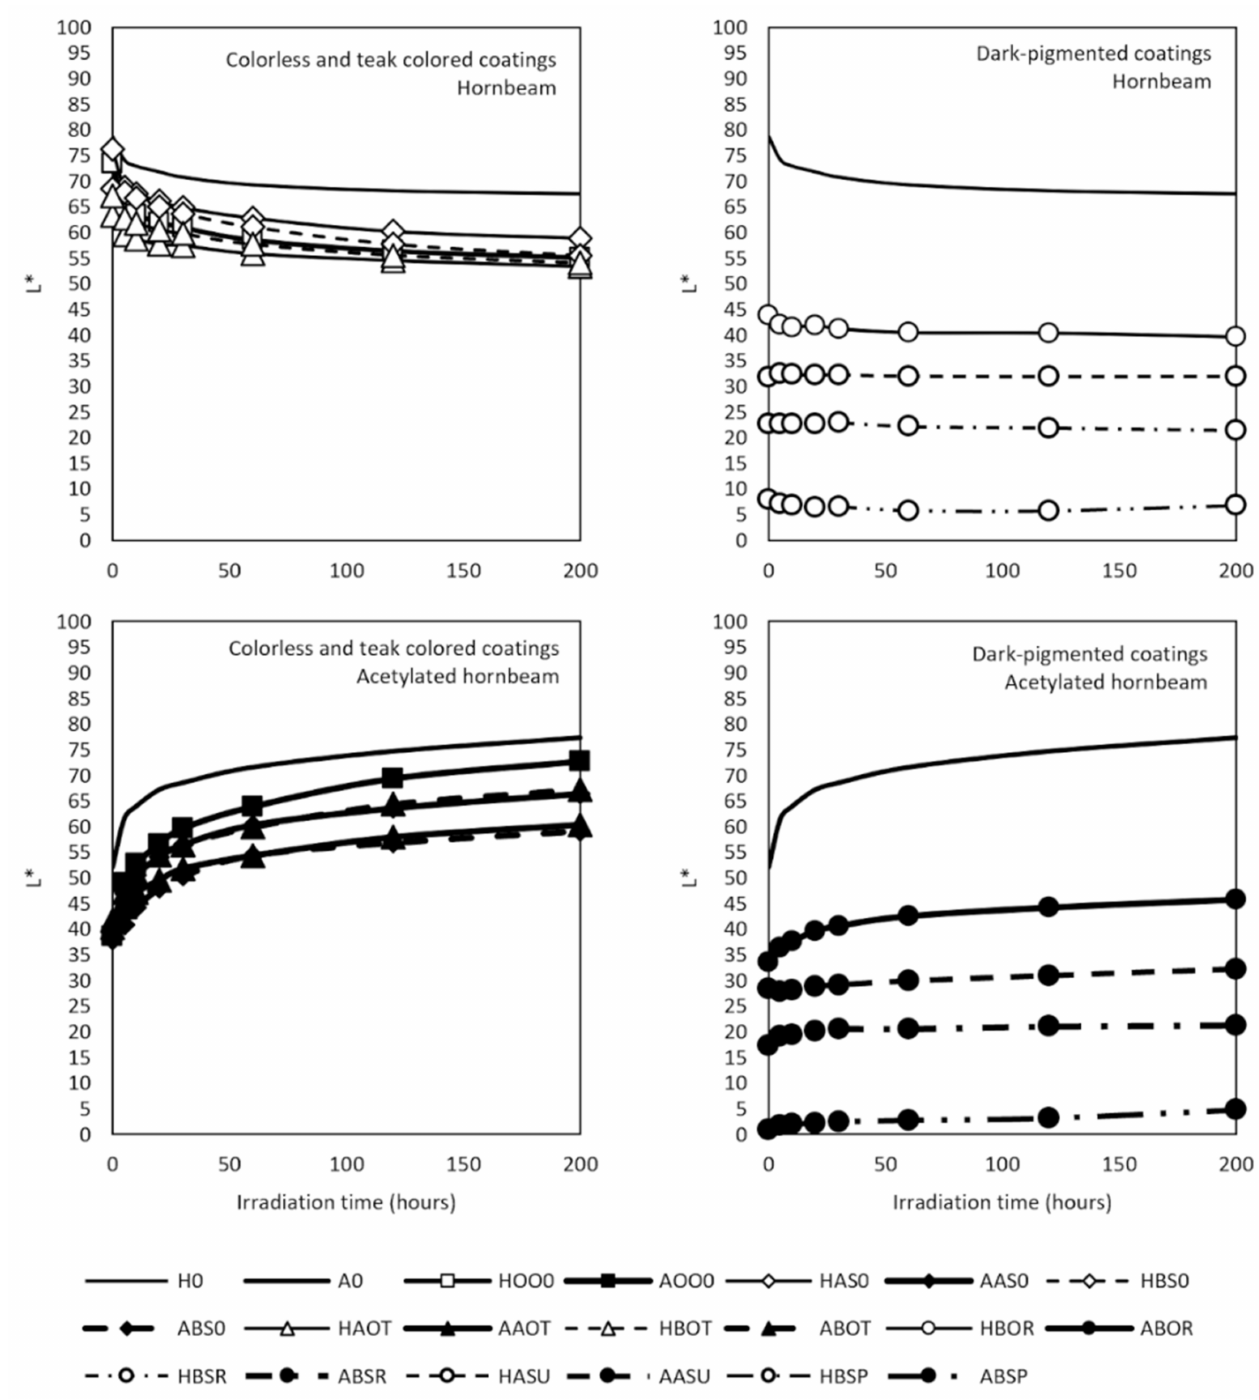
Figure 3. Change of lightness (L*) during 200 h of xenon lamp irradiation. The value of color variation–the color difference calculated compared to the average color–indicated how variable the initial color is. There were no remarkable differences found between the initial color variation of uncoated and coated wood, or untreated and acetylated hornbeam, and all values were lower than 5 (Table 4). After irradiation, the color variation was higher in acetylated hornbeam compared to untreated